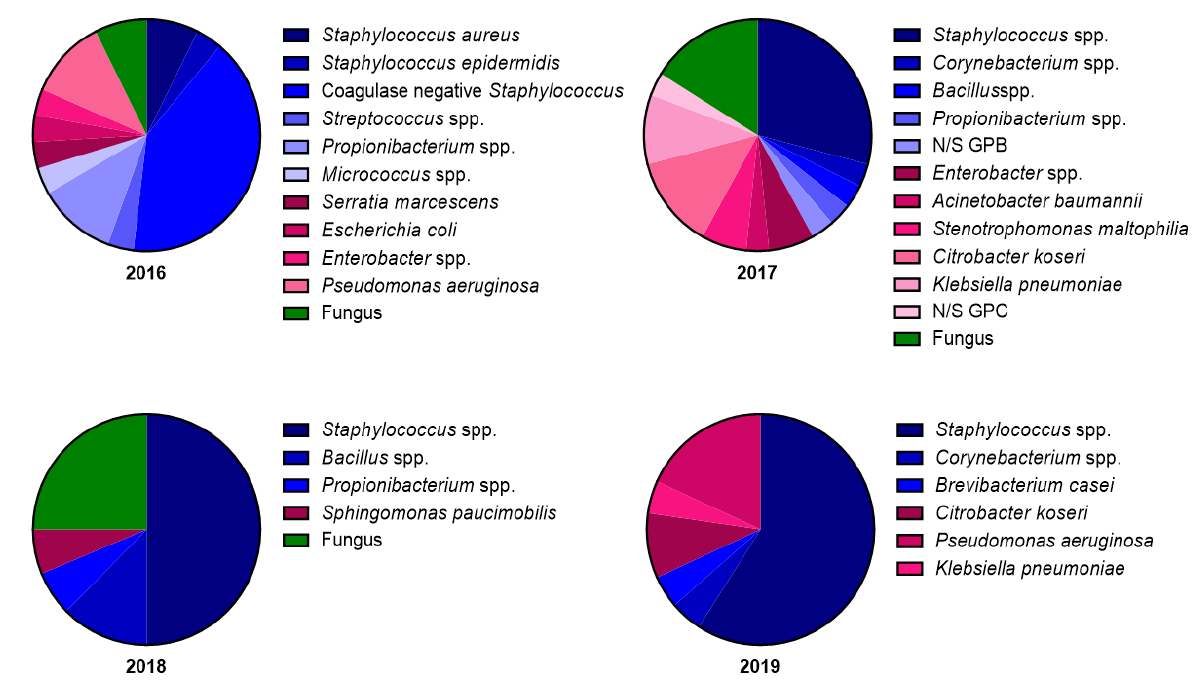
Figure 2. Composition statistics of microbial strains in cases positive for microbial contamination. We identified 11 and 12 microbial strains in 2016 and 2017, respectively, from the extraocular side of corneoscleral rim sampling. We identified 5 and 6 microbial strains in 2018 and 2019, respectively, from the intraocular side of corneoscleral rim sampling. N/S, non-specific; GPB, Gram-positive bacillus; GNC, Gram-negative cocci.